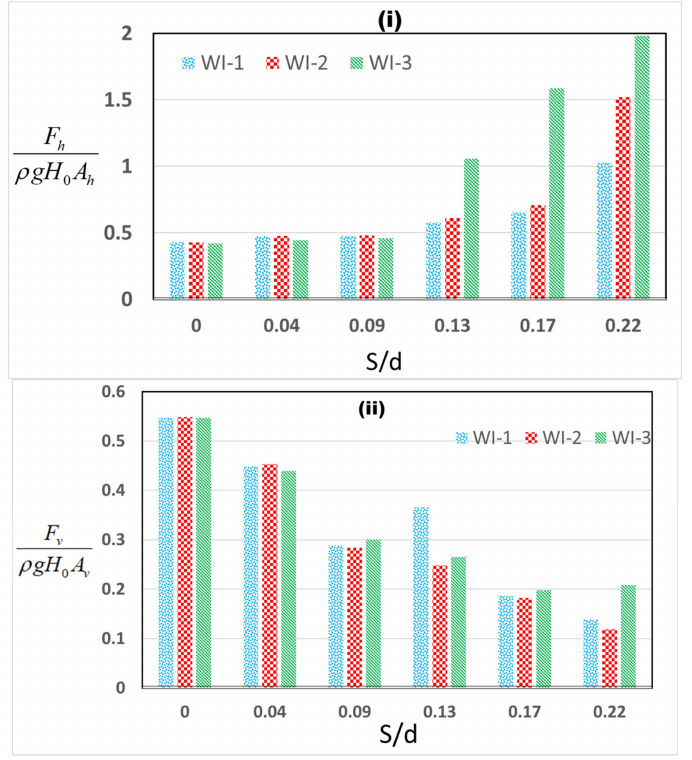
Figure 21. ( i ) Peak horizontal and ( ii ) Peak vertical impact force at different airgaps ( S/d = 0, 0.04, 0.09, 0.13, 0.18 and 0.22) for three different breaking wave impact scenarios: WI-1, WI-2 and